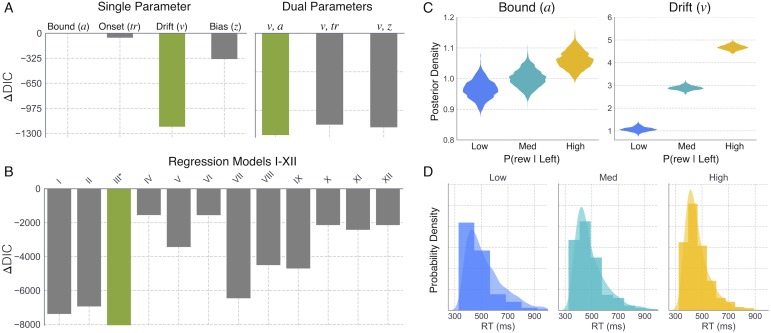
Model comparison and fits to randomly sampled network data.A. ΔDIC values for all single (left) and dual (right) free parameter models. B. ΔDIC values for DDM regression models I − XII associated with parameters (v, a). C. Posterior distributions for boundary height (a) and drift rate (v) estimated in the best-fitting regression model III. D. Correct RT distributions generated by the sampled networks (histograms) with predicted distributions from regression model III overlaid as kernel densities for each reward condition (see Fig 5 for corresponding model fit results from original network data).